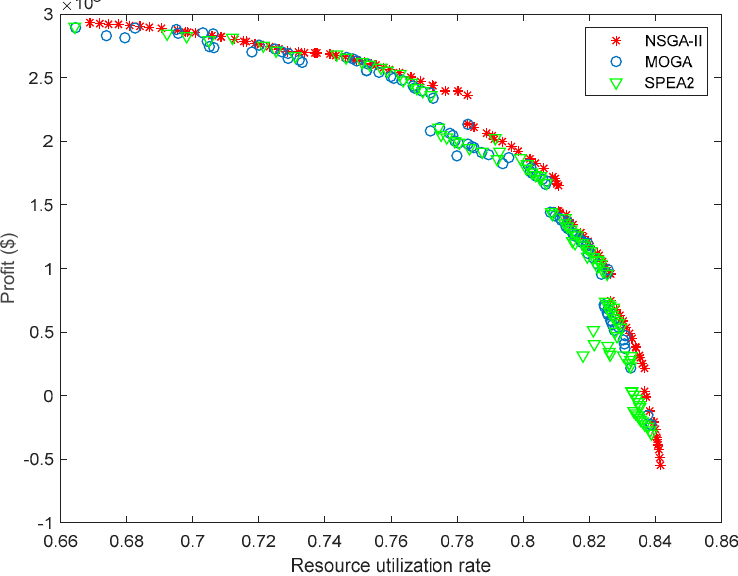
Figure 13. The Pareto-optimal solutions obtained by NSGA-II, Multi-Objective Genetic Algorithms (MOGA), Improved Strength Pareto Evolutionary Algorithm SPEA2.